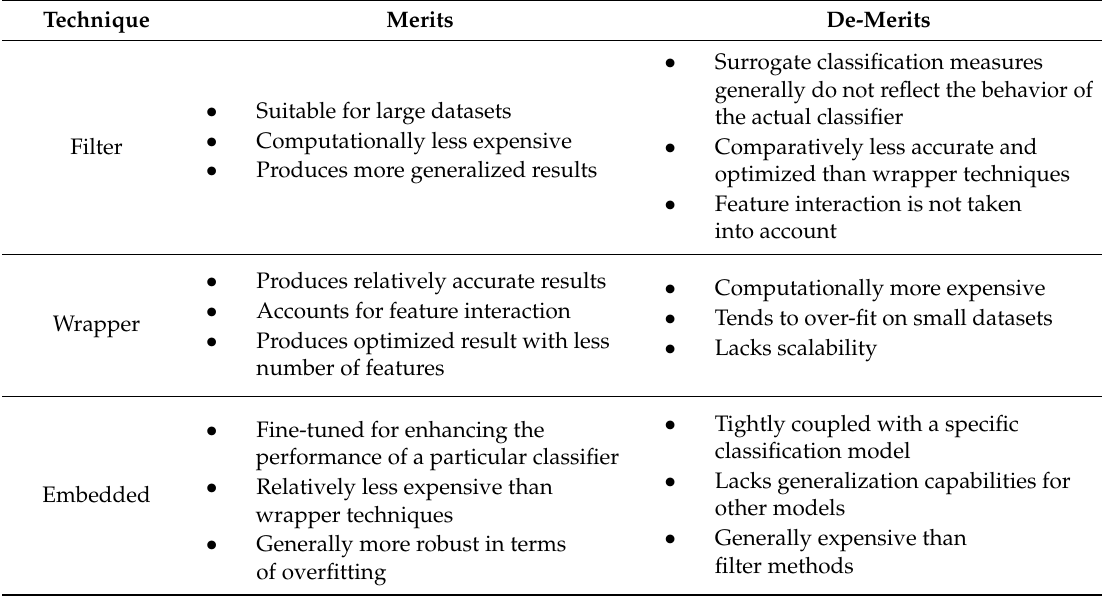
Table 1. Comparison among di ff erent feature subset selection